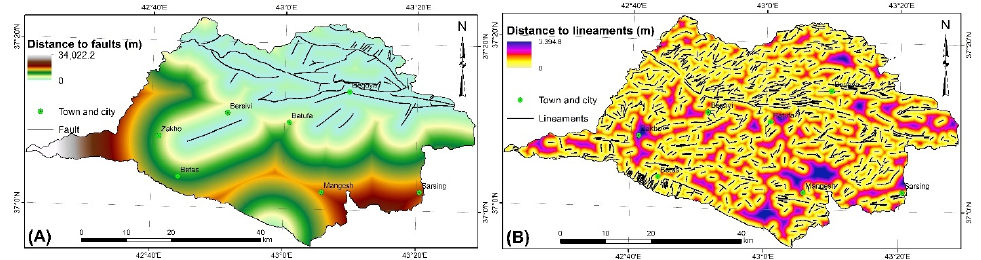
Figure 4. Maps of ( A ) distance to faults, ( B ) distance to lineaments.